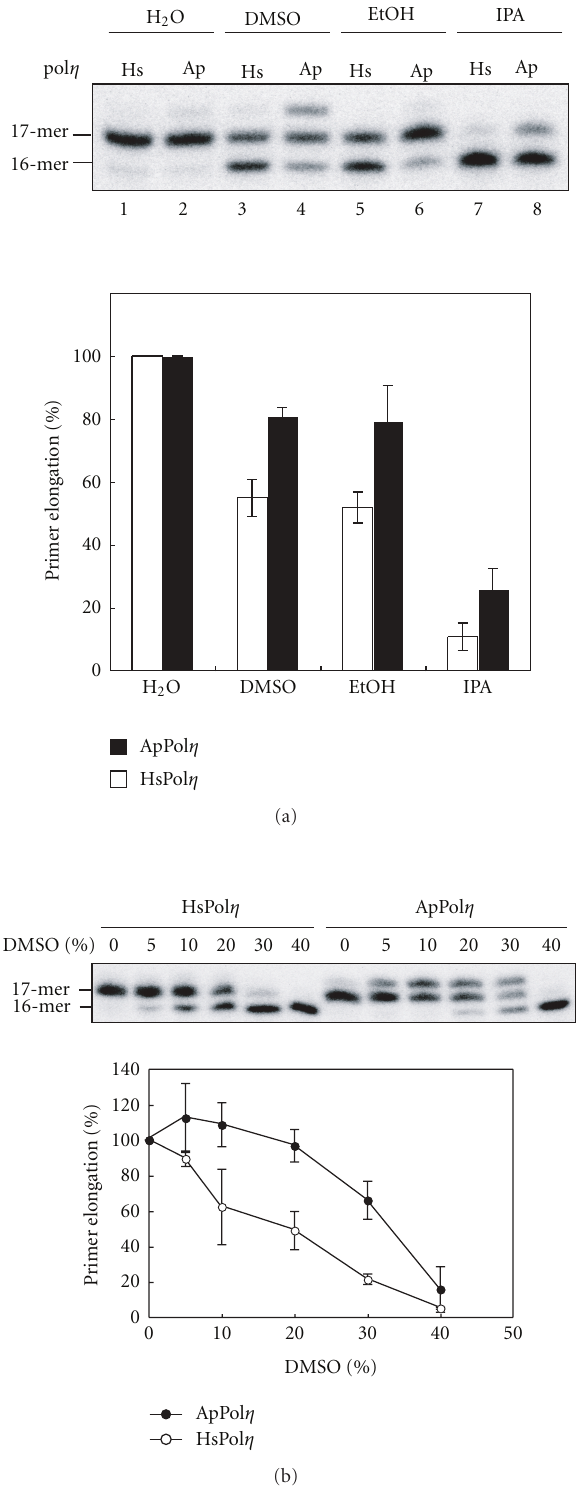
Figure 8: Activity of ApPol η in organic solvent-containing solu- tions. (a) Incorporation of dCMP in the presence of DMSO, ethanol, and IPA at a concentration of 20% (v/v) was analyzed, using the primer-template shown in Figure 7. Replication assays were performed at 30 ◦ C for 10 minutes. (b) The same assays were performed with various concentrations of